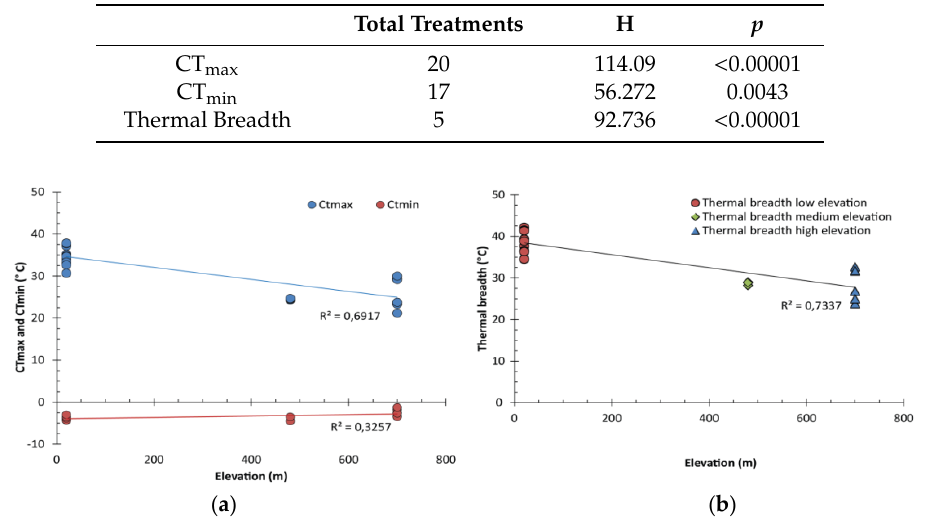
Supplementary Materials.